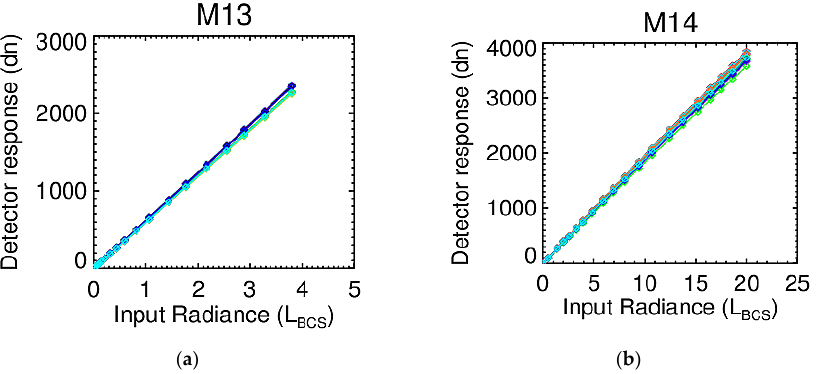
Figure 7. Detector response (dn) versus blackbody calibration source (BCS) radiance (L BCS ) for S-NPP VIIRS thermal emissive bands (TEB) M13 and M14. Radiance unit: W·m −2 ·µm −1 ·sr −1 (see text for details) . Different colors represent different detectors.